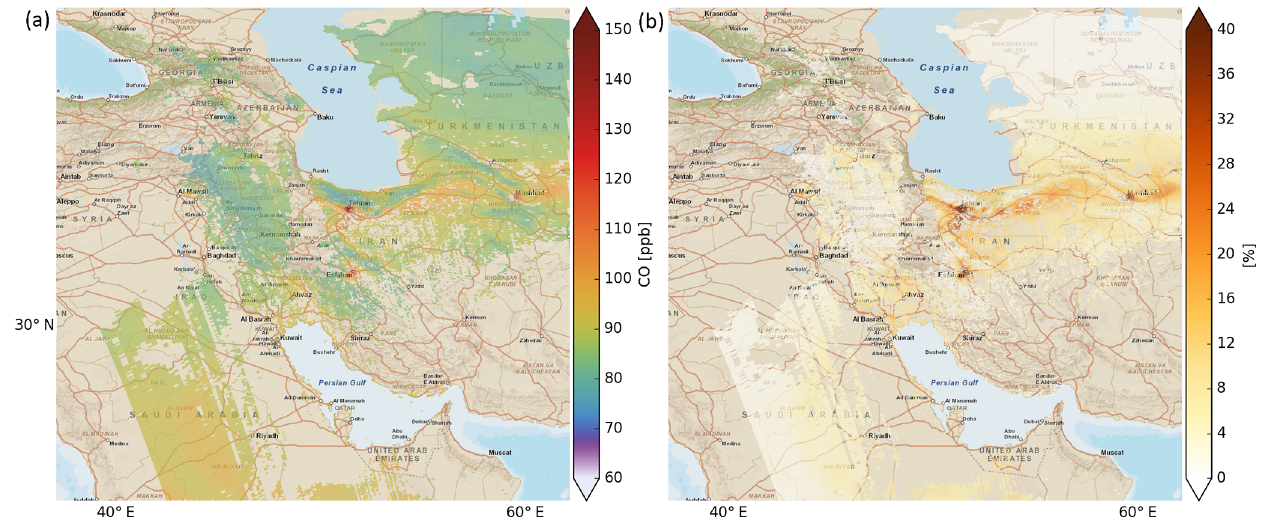
Figure 4. WRF simulation for 18 December 2017 09:37UTC collocated and fitted to the TROPOMI data (a) , and the relative difference of the WRF simulated total column to the background CO tracer column (100 × (WRF −